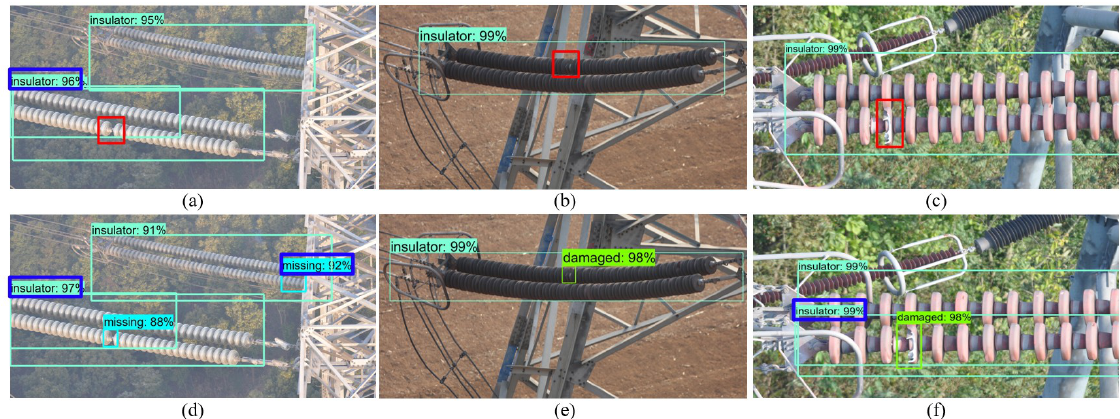
Figure 9. Qualitative result comparison for defects detection. ( a – c ) baseline detection results; ( d – f ) MGRN detection results.